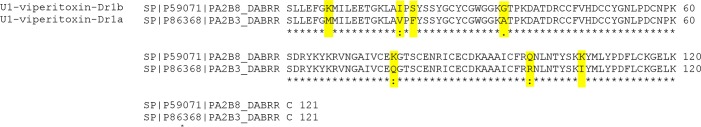
Alignment of U1-viperitoxin-Dr1b amino acid sequence with U1-viperitoxin-Dr1a.Sequences were obtained from UniProt database and are presented with unique identification numbers and entry names. In residues marked as ‘*’ are single fully conserved residues. At the positions highlighted in yellow, ‘:’ and ‘.’ denote positions with conservation between groups of strongly similar properties (scoring > 0.5 in the Gonnet PAM 250 matrix) and, conservation between groups of weakly similar properties (scoring = < 0.5 in the Gonnet PAM 250 matrix) respectively.